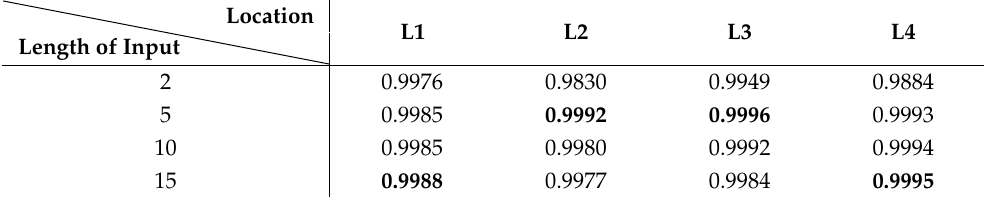
Table 2. R 2 variation of different input lengths at different positions, where the bold font is the maximum value of each column.